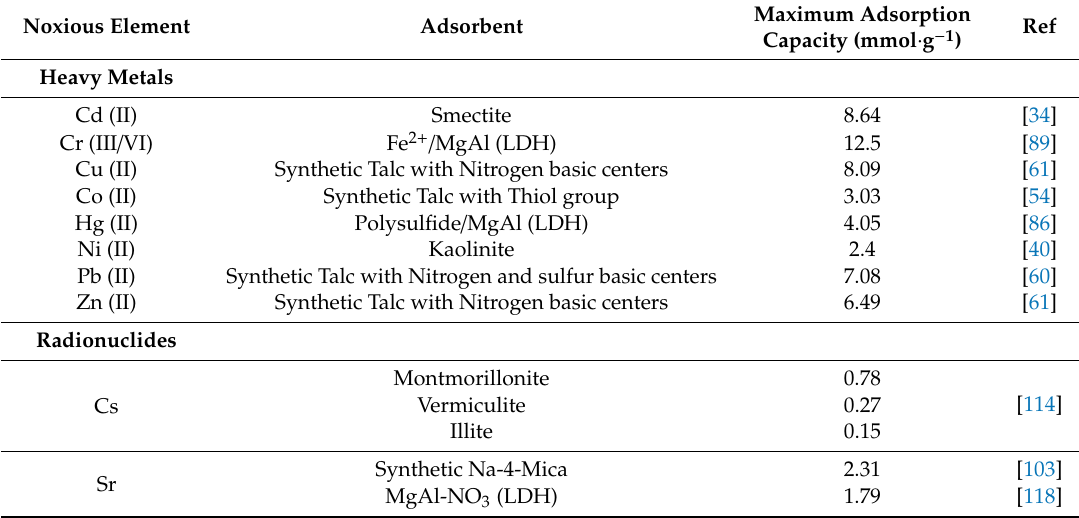
Table 5. Summary of best adsorption capacities of heavy metals and radionuclides by phyllosilicates and